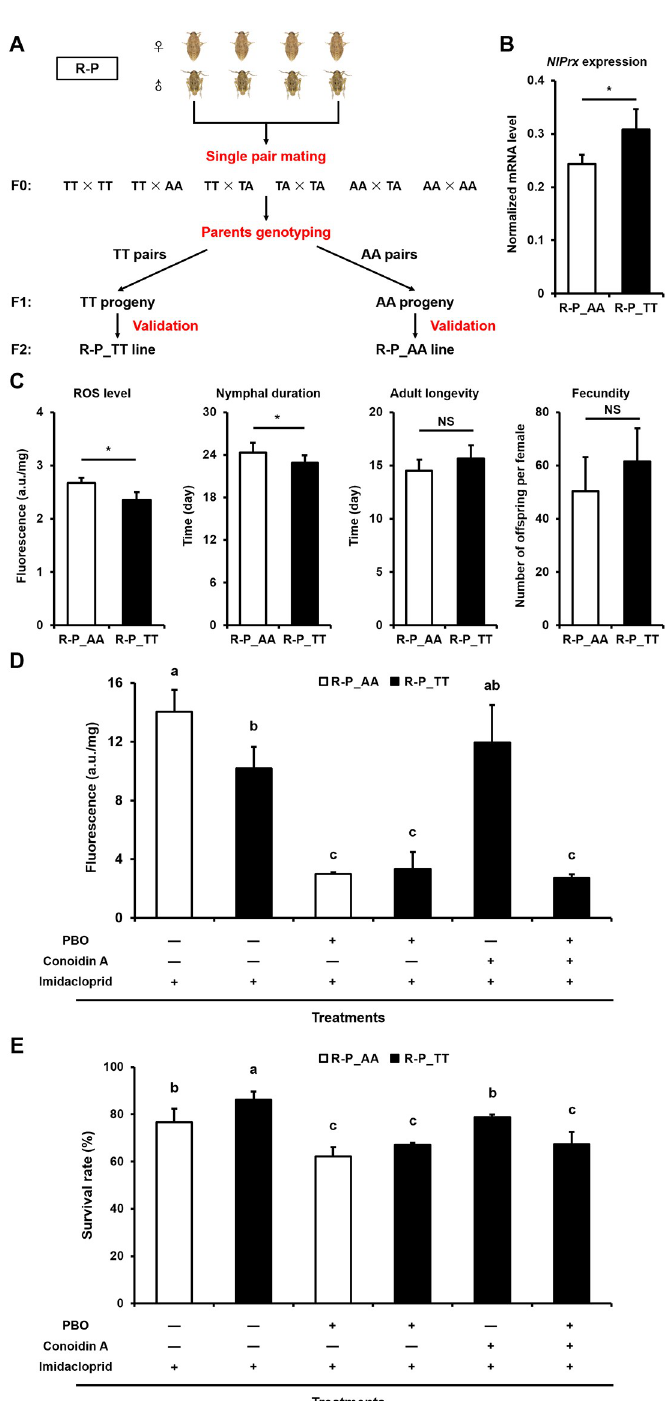
Fig 4. Comparison of the life history traits, ROS levels, and survivorship of the R-P_TT and R-P_AA isogenic lines under different treatment regimes. (A) Schematic diagram for establishment of R-P_TT (with homozygous NlPrx T65549 alleles) and R-P_AA (with homozygous NlPrx 65549A alleles) isogenic lines from the highly resistant R-P population. (B) The NlPrx mRNA level of R-P_TT was compared to that of R-P_AA. (C) Comparison of the life history traits and ROS levels of the R-P_TT and R-P_AA lines under normal rearing conditions. (D) Comparison of the ROS levels of the R-P_TT and R-P_AA lines treated with 10 mg/l imidacloprid alone, 10 mg/l imidacloprid + 5 mg/l PBO, 10 mg/l imidacloprid + 0.1 mmol Conoidin A , or 10 mg/l imidacloprid + 5 mg/l PBO + 0.1 mmol Conoidin A . For all the mixture treatments, 1-day-old female adults of both lines were pre-exposed to PBO and/or Conoidin